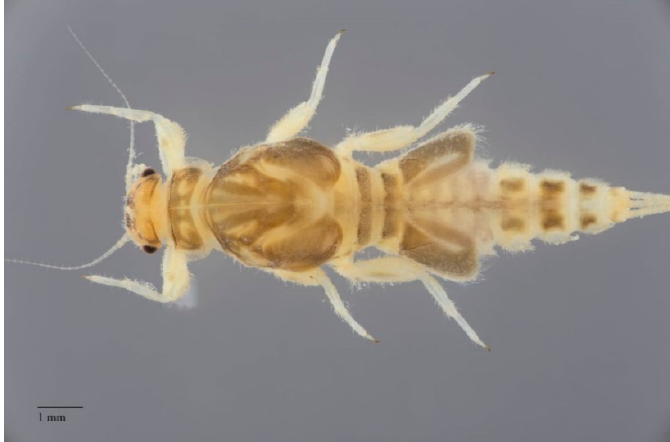
Figure 8. Larva of Cheirogenesia edmundsi Sartori & Elouard (Palingeniidae, Madagascar) in dorsal view; a burrower which digs into hard substrates, such as clay.